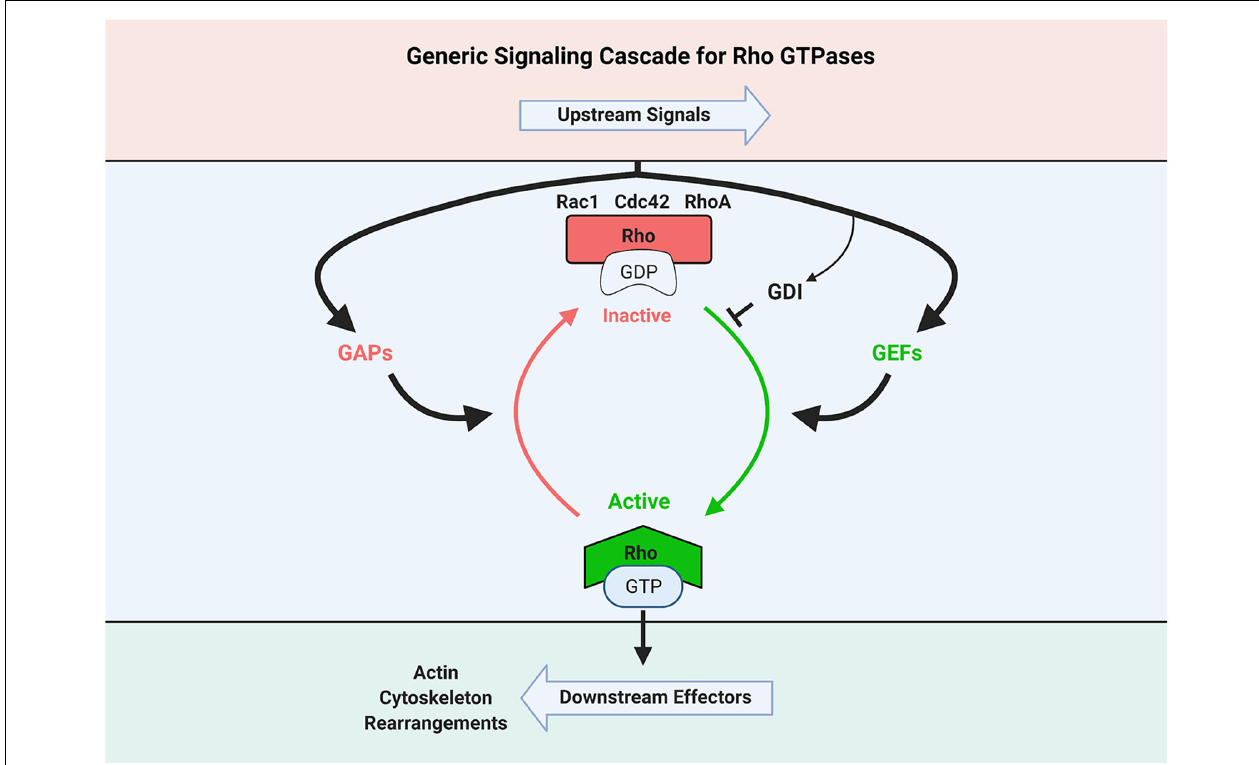
FIGURE 1 | Schematic illustration of Rho GTPase activation and inactivation signaling cascade. GEF, Guanine nucleotide exchange factor; GAP, GTPase-activating protein; GDI, GTPase dissociation inhibitor. Created with